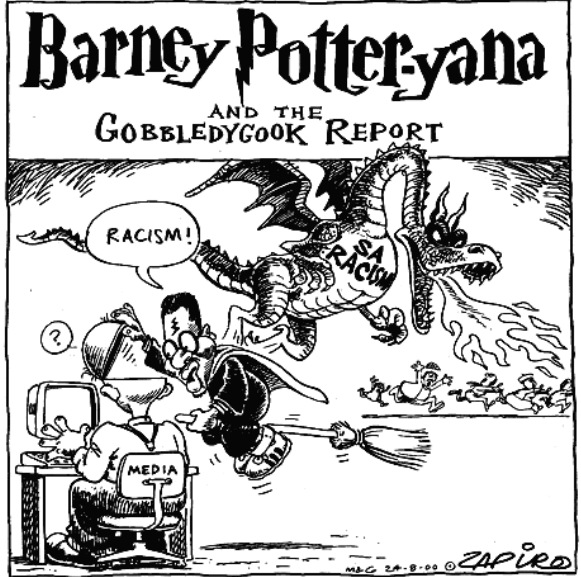
Figure 3: Jonathan Shapiro. Mail and Guardian. 25 August